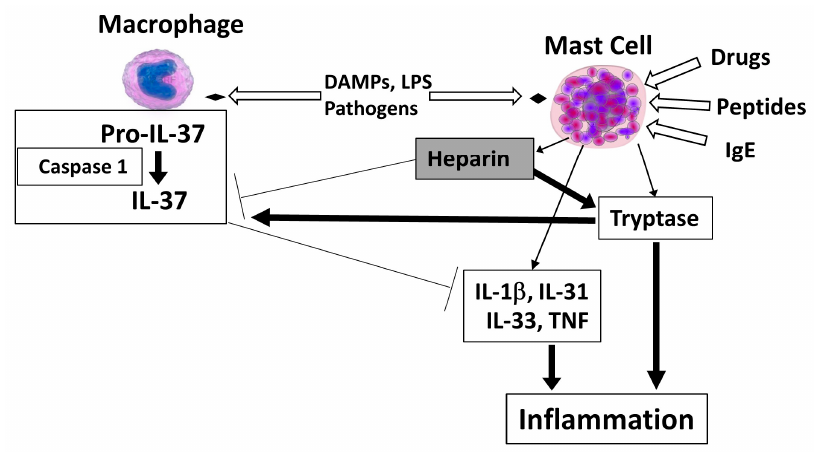
Figure 1. Diagrammatic representation of the role of mast cell-derived heparin in the regulation of the activity of IL-37. Activation of caspase 1 in macrophages, in response to TLR activation, leads to cleavage of pro-IL-37 to mature IL-37, both of which are secreted outside the cell and have anti-inflammatory activity. In the tissue microenvironment, mast cells secrete heparin, which interacts with IL-37 and promotes the formation of inactive homodimers. Mast cells also secrete the proteolytic enzyme tryptase, which exists as homotetramer bound to heparin and promotes inflammation by acting on protease-activated receptors (PAR). In the absence of heparin, biologically active tryptase monomers may be able to generate IL-37 forms with increased anti-inflammatory activity. Open arrows = activation; thin arrows = secretion; thick arrows = stimulation; T arrows = inhibition.